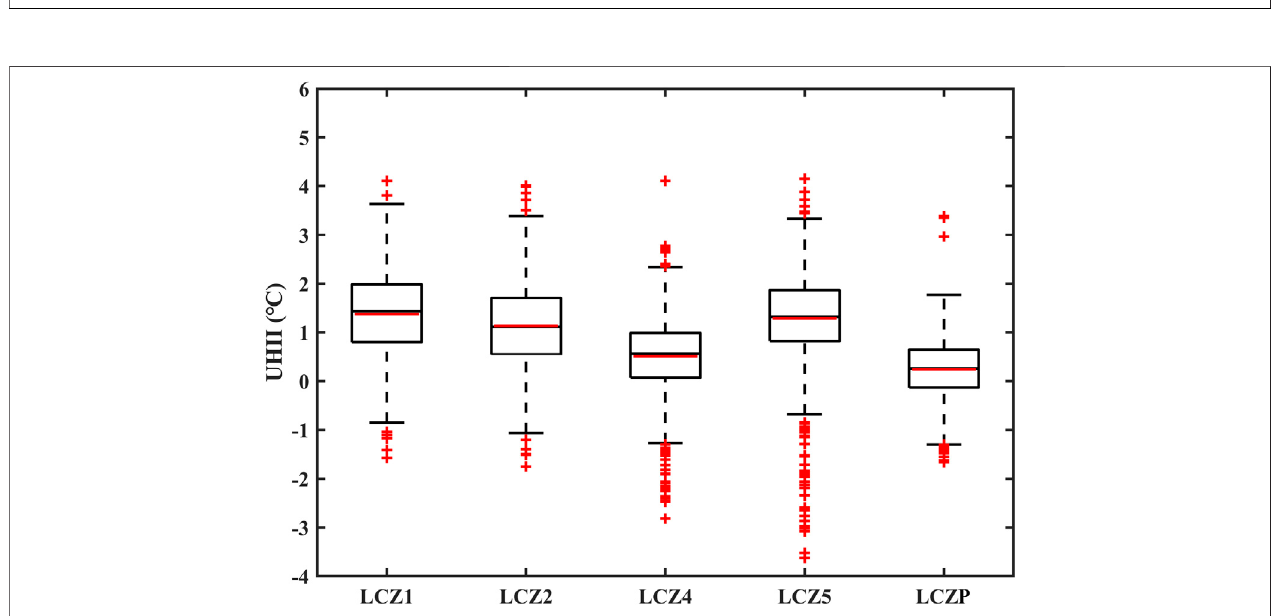
FIGURE 6 | Number and duration of HW events under each LCZ.